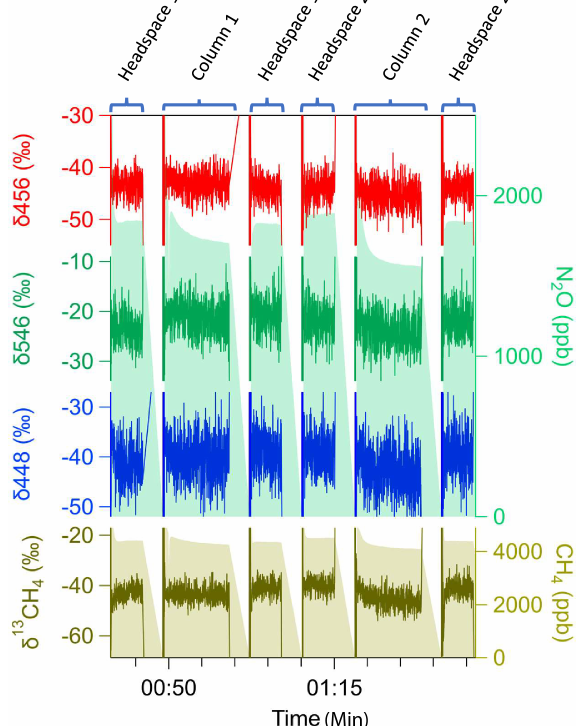
Figure 9. Soil probe sampling approach upscaled to multiple probes (System 2). Multiprobe tests measured headspace–probe– headspace sequentially for (top panels) N 2 O (green shade, right side) including isotopic ratios for three N 2 O isotopomers δ 456 (red), δ 546 (green), and δ 448 (blue) and (bottom panel) δ 13 C CH 4 (brown, left axis) and CH 4 (brown, right